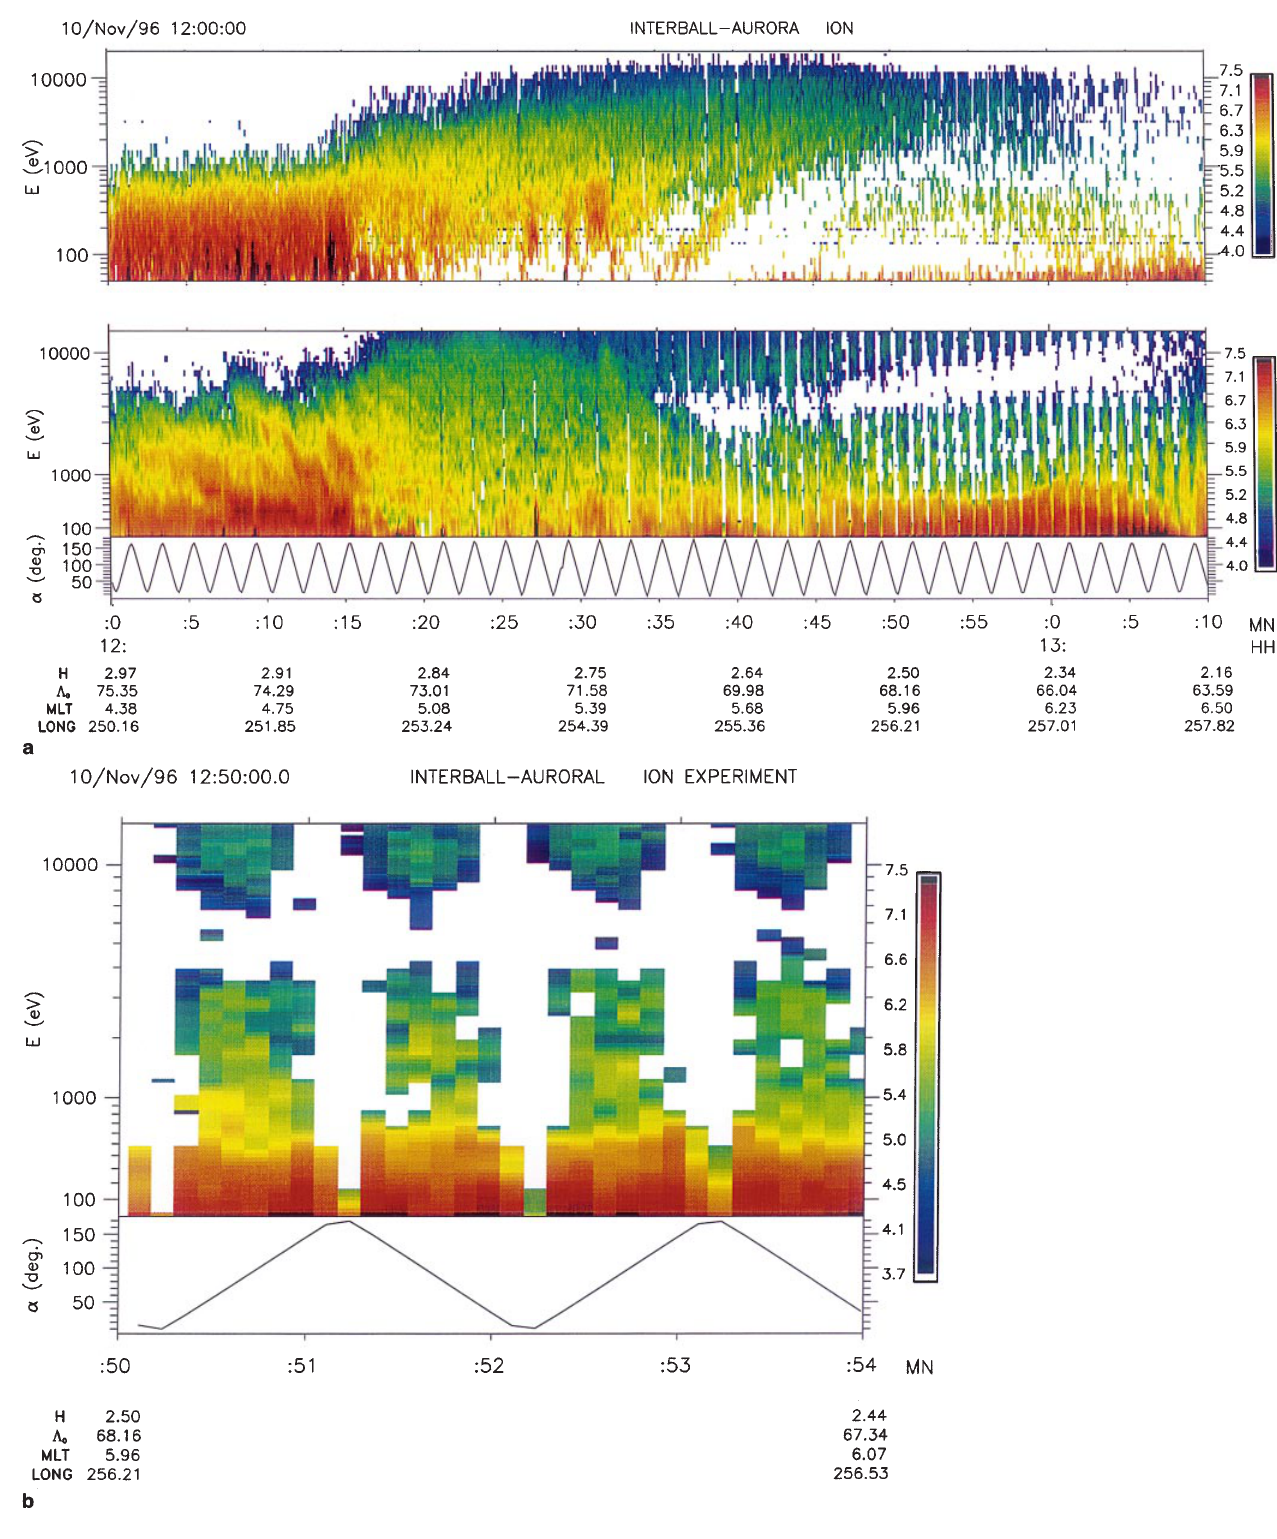
given for the ions. b Ion energy time spectrogram during a two spin period (from 1250 UT to 1254 UT) for the November 10, 1996 pass (see